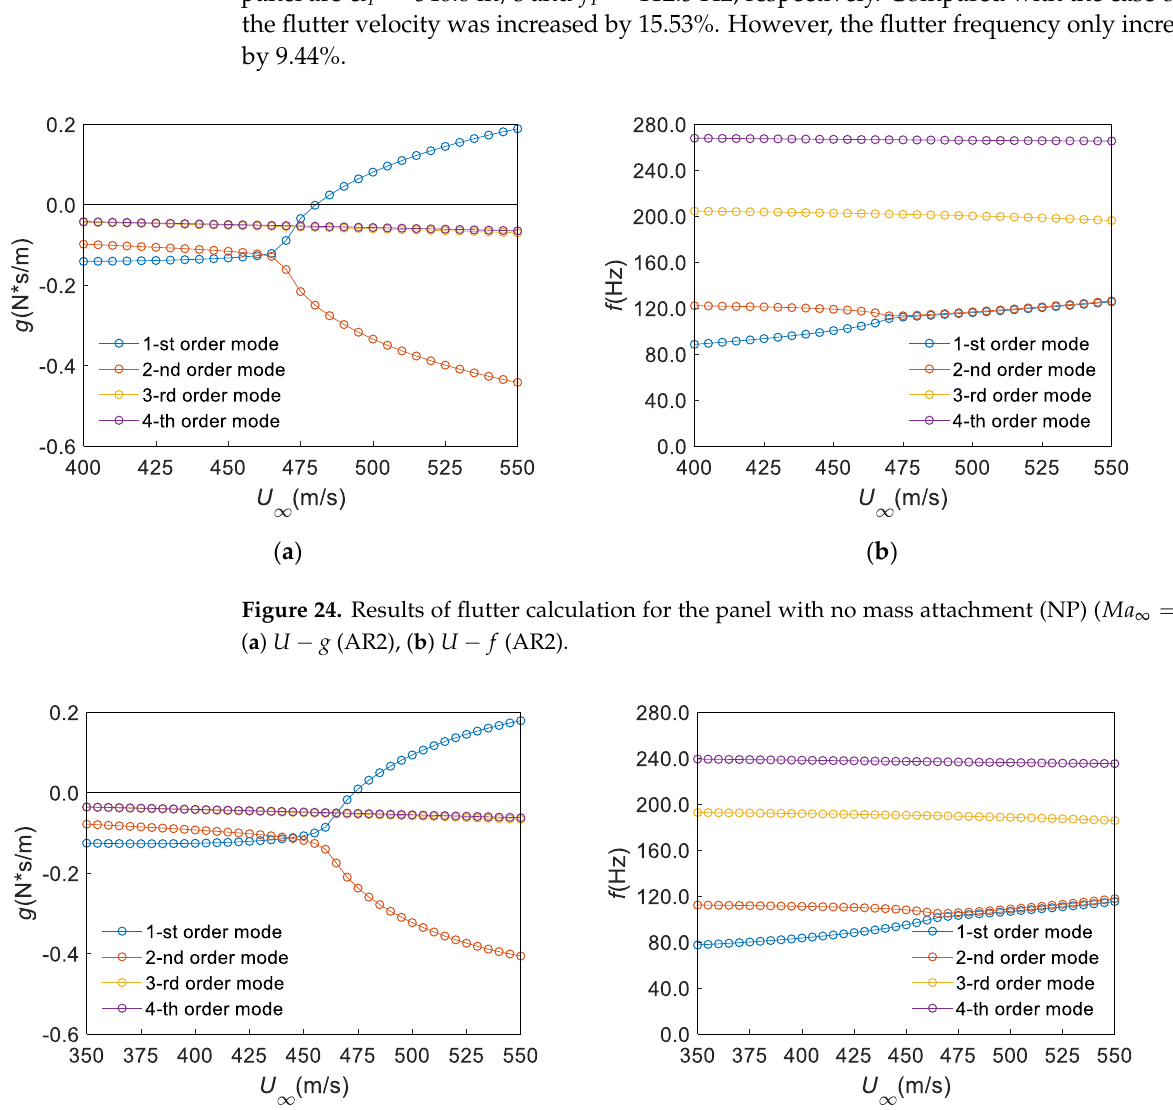
Figure 23. Results of flutter calculation for the panel with the 9P method damper configuration ( 2.0 Ma  